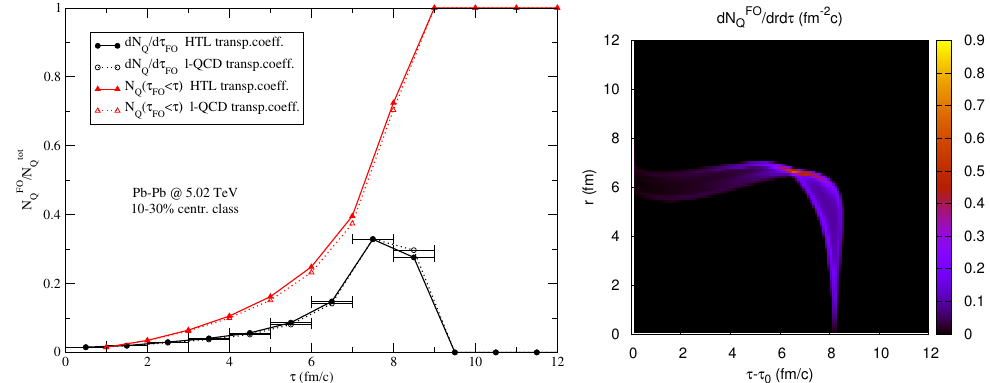
Figure 3 . Left panel: the decoupling-time distribution of charm quarks escaping from the (cid:12)reball p produced in semi-central Pb-Pb collisions at s NN = 5 : 02 TeV for di(cid:11)erent choices of transport coe(cid:14)cients. Right panel: the (cid:28) (cid:0) r correlation of charm quarks decoupling from the (cid:12)reball for the same centrality class and HTL transport